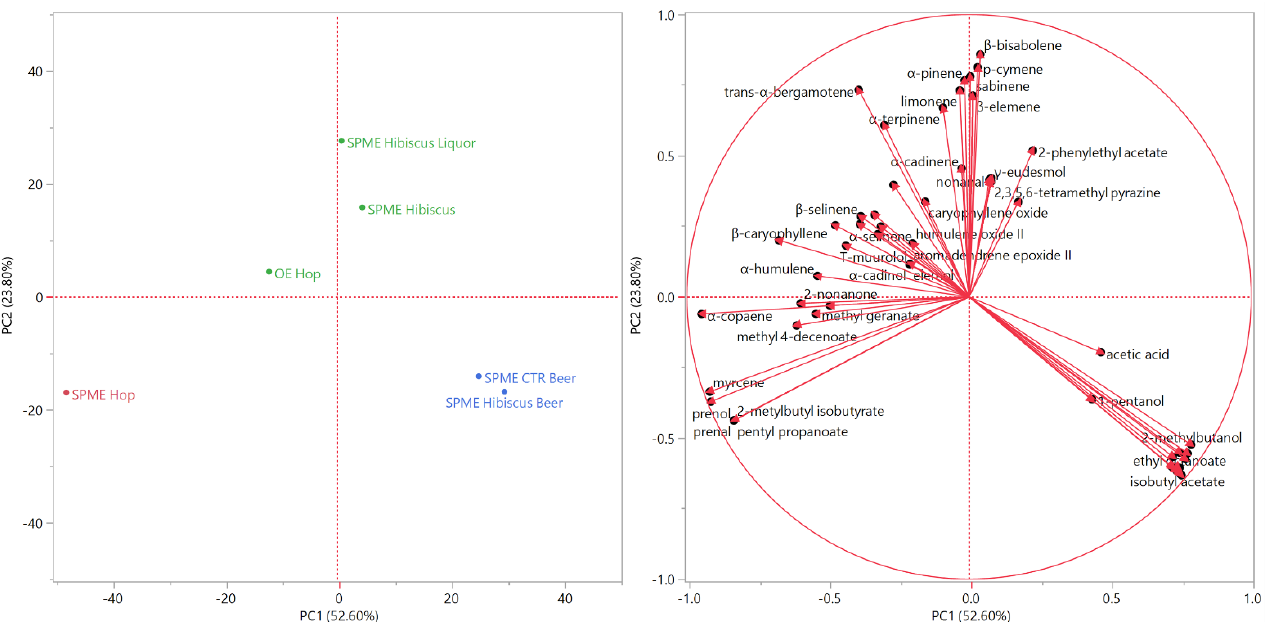
ported in Figure 4.